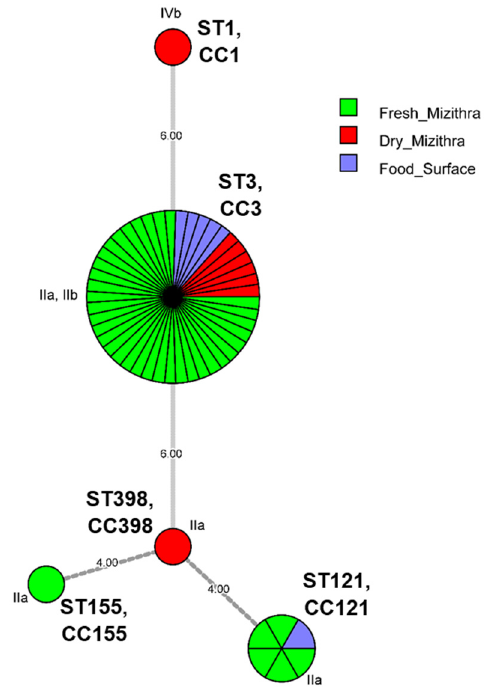
Figure 4. Minimum spanning tree (MST) based on MLST allelic profiles of L. monocytogenes isolates. The MST illustrates the phylogenetic relationship of the isolates, which are depicted in circles (each circle representing an ST and its homologous CC) with different colors (whether it is a surface or end-product isolate), the size of the circle being proportional to the number of strains belonging to the ST (CC). The circle fragments correspond to the different isolates. Links between the circles represent the number of allelic mismatches between STs (CCs).